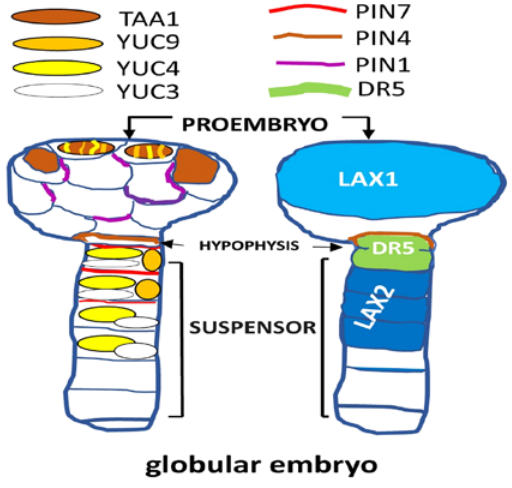
Figure 2. Dynamic of expression and localization (i.e., proembryo, hypophysis and suspensor) corresponding to several genes for the biosynthesis and transport of auxins in Arabidopsis embryos at the globular stage. LIKE-AUX1/2 (LAX1/2); highly active synthetic auxin response element (AuxRE), is referred to as DR5; auxin efflux carrier PIN-FORMED (PIN); YUCCA (YUC); TRYPTOPHAN AMINOTRANSFERASE OF ARABIDOPSIS (TAA1).